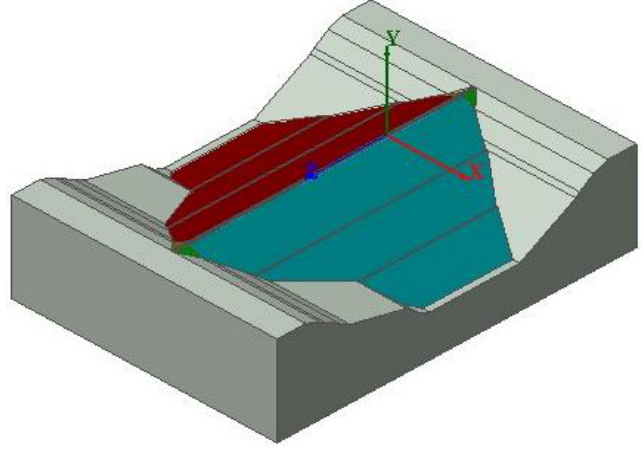
Figure 4. Main dam body and the dam x-section.